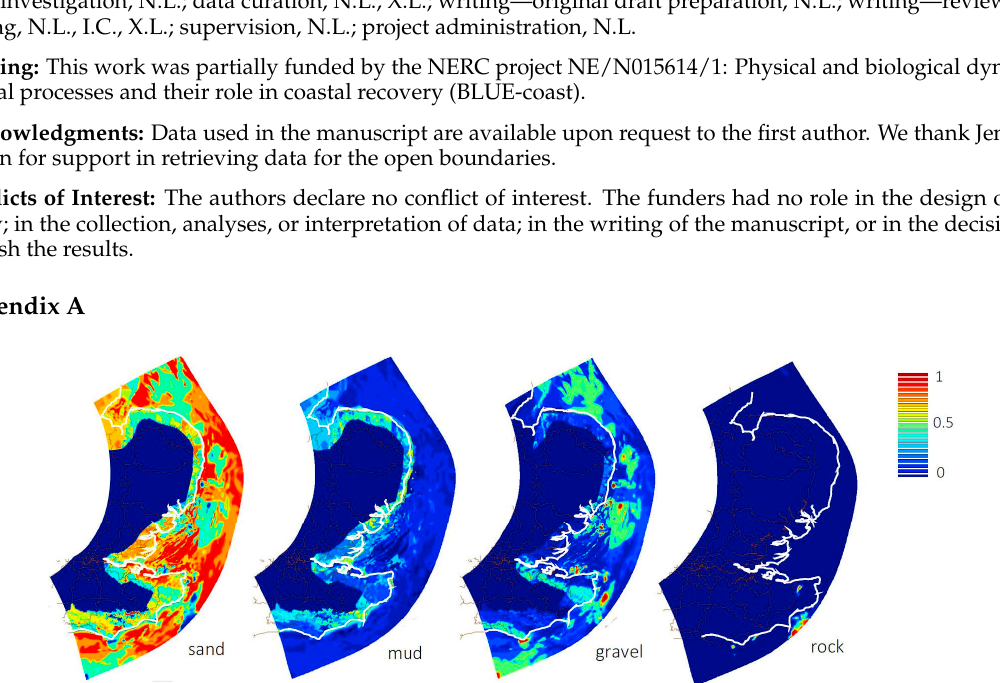
Figure A1. Percentage values of different sediment fractions at the bottom (adapted from Leonardi and Plater [60]).